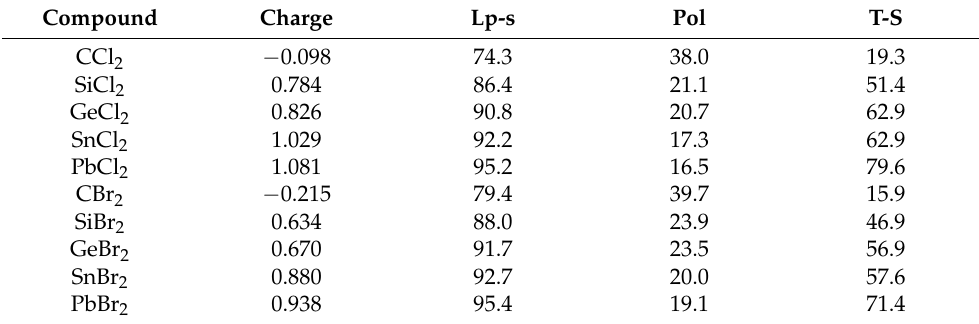
Table 2. The NBO characteristics of the dihalometallylenes; charge of the tetrel center is given (au), Lp-s is the percentage of the s-character of the lone electron pair orbital, Pol is the polarization of the tetrel-halogen (Z-X) bond defined as the percentage of the electron density of the bond orbital at the tetrel center. These are the BP86-D3/TZ2P results of calculations for systems optimized at the MP2/aug-cc-pVTZ level. T-S designates the difference in energy between the triplet and singlet states (in kcal/mol, MP2/aug-cc-pVTZ